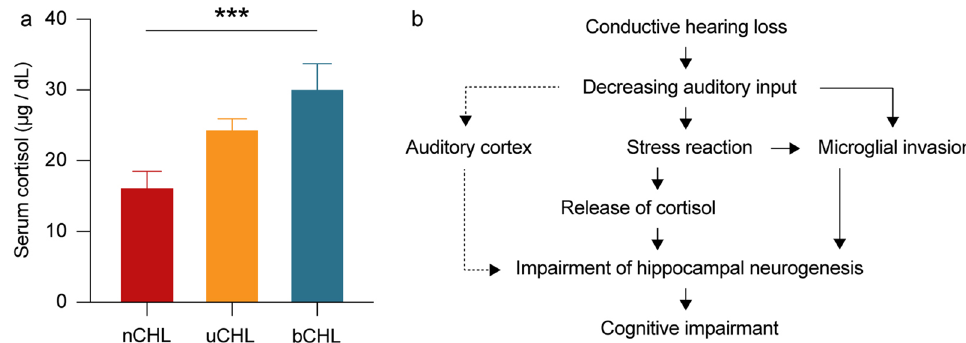
Figure 5. Serum cortisol concentrations one week after ear occlusion ( a ) and proposed mechanisms of hippocampal neurogenesis impairment following CHL ( b ). ( a ) Concentrations of serum cortisol were significantly higher in the bCHL group compared to that in the nCHL group. There were no significant differences between the nCHL and uCHL groups or the uCHL and bCHL groups (n = 5 per each group). *** p < 0.001. DG, dentate